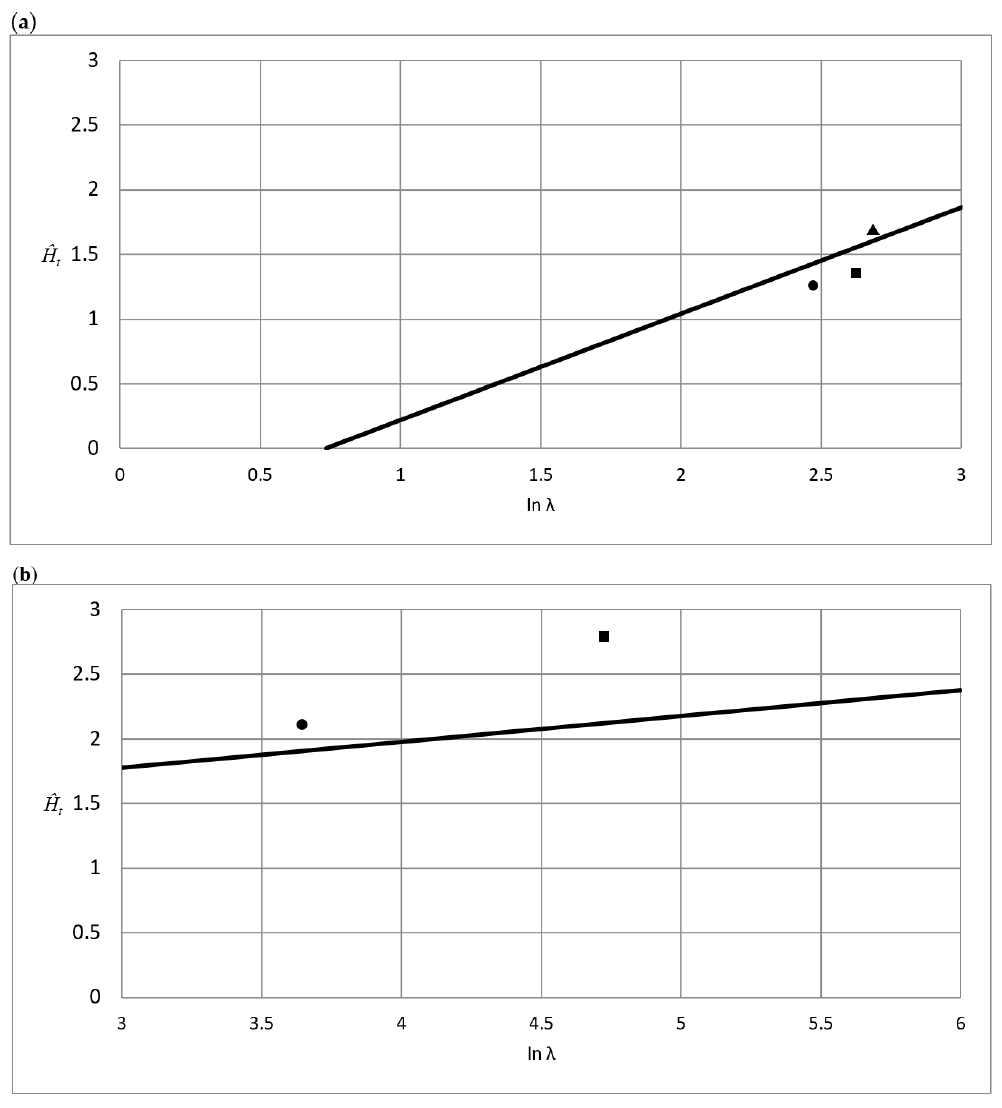
Figure 6. Normalized tangential scratch hardness, Ĥ t = H t / σ rep , as function of ln Λ where Λ is the Johnson parameter defined in Equation (1). Results taken from Wredenberg and Larsson [20]. ( a ) The representative stress was determined from σ rep = σ ( ε p = 0.25). The thick line represents upper Equation (10). ( ● ), experimental results for PMMA as detailed in Table 1. ( ■ ), experimental results for epoxy as detailed in Table 1. ( ▲ ), experimental results for vinyl ester as detailed in Table 1. ( b ) The representative stress was determined from σ rep = σ ( ε p = 0.39). The thick line represents lower Equation (10). ( ● ), experimental results for Al7050 as detailed in Table 1. ( ■ ), experimental results for stainless steel as detailed in Table 1.